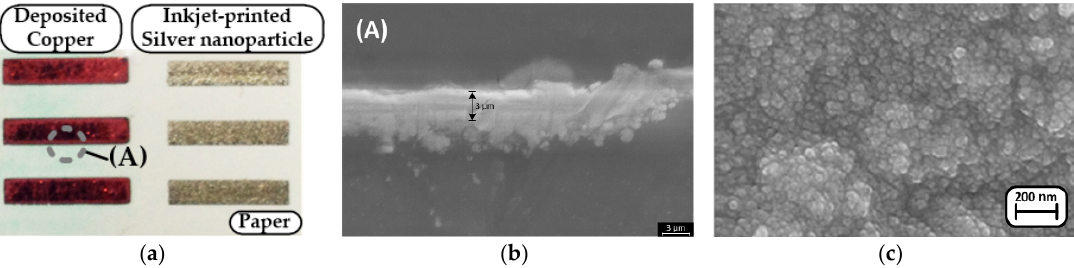
Figure 6. ( a ) The deposited copper traces (50 min) utilizing the palladium catalyst ink in comparison with the inkjet-printed silver nanoparticle traces. ( b ) Cross section and ( c ) surface of the copper grown on the cellulose-based paper.